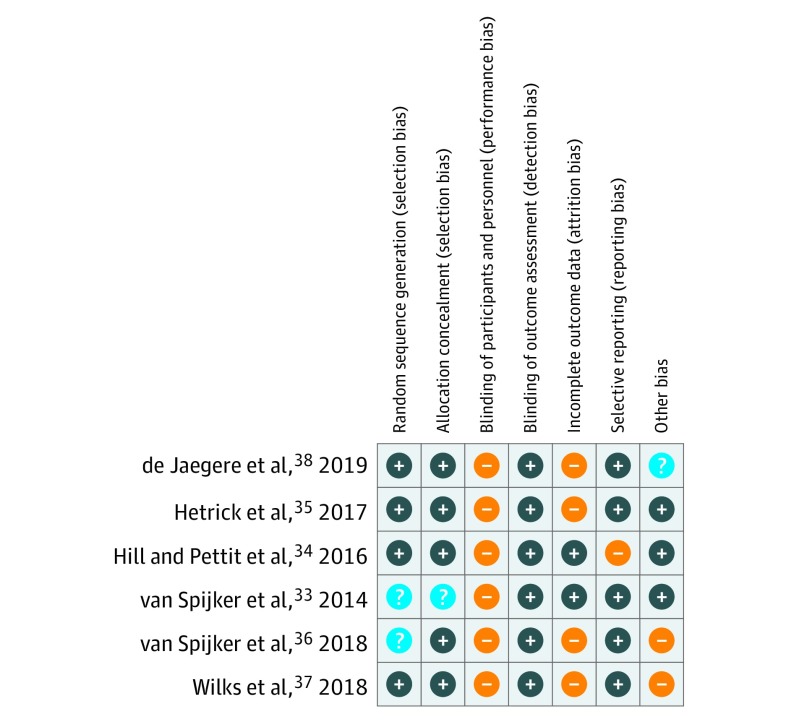
Risk of Bias SummaryRatings were performed using the Cochrane Risk of Bias Tool. Plus sign indicates low risk of bias; minus sign, high risk; and question mark, unclear.